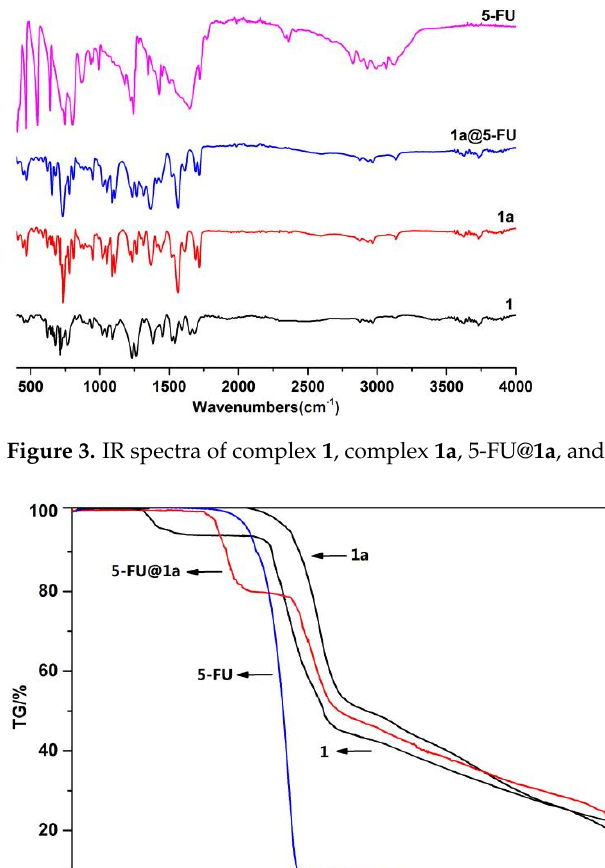
Figure 4. TGA curves of complex 1 , complex 1a , 5-FU, and 5-FU@ 1a .